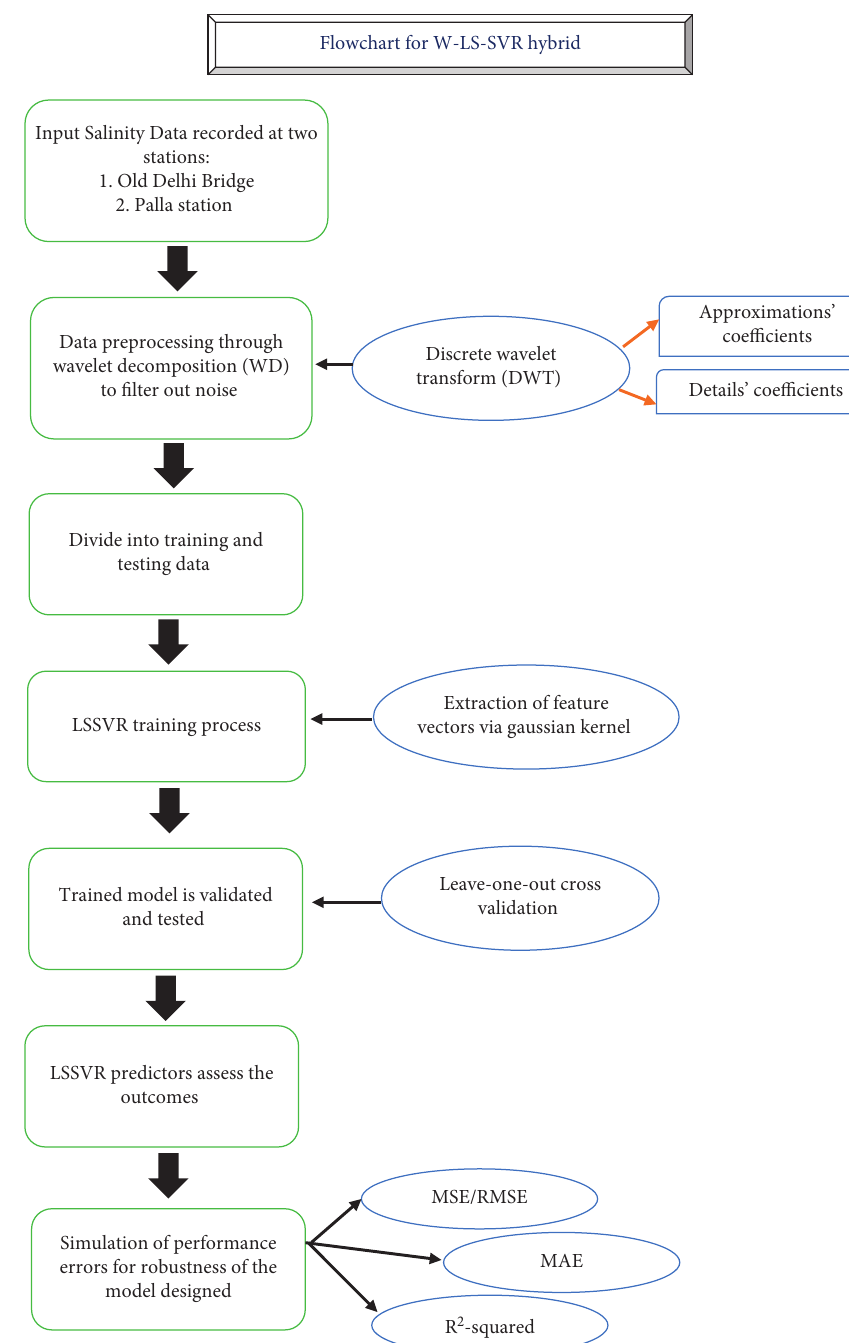
Figure 3: Flowchart of wavelet LSSVR